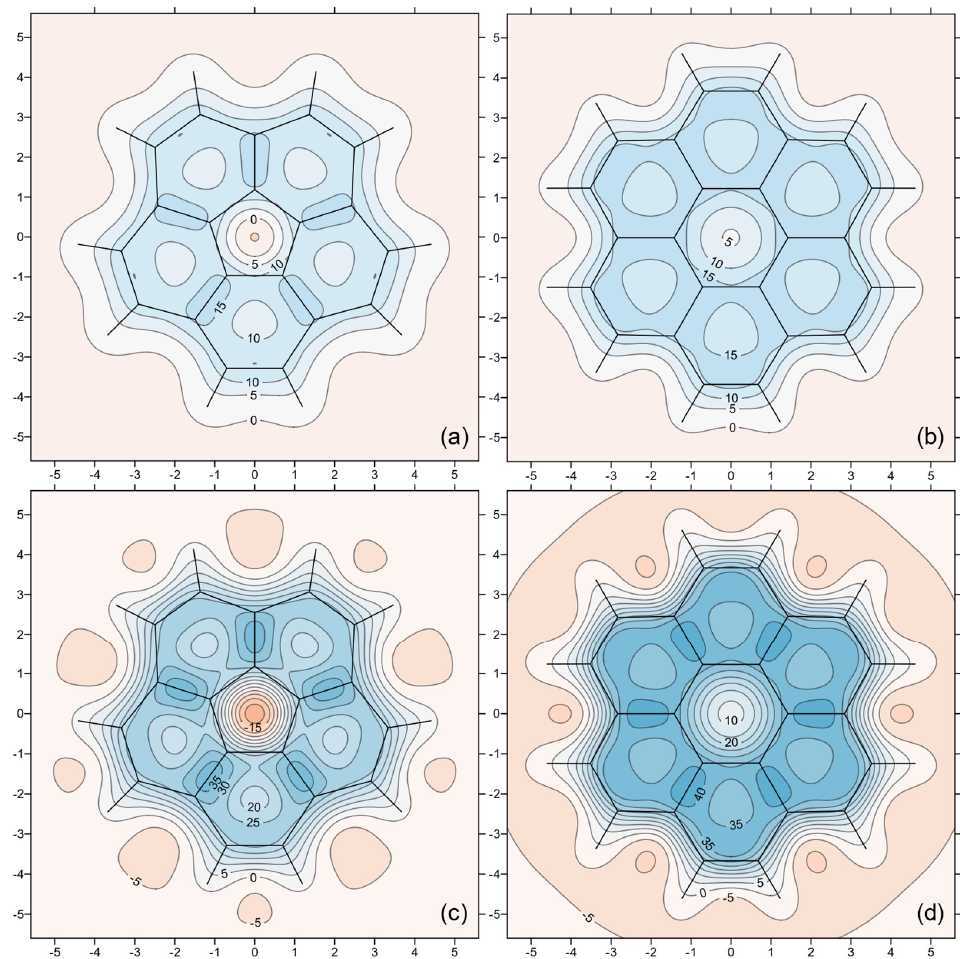
Figure 5. σ iso ( r ) ( a , b ) and σ zz ( r ) ( c , d ) contour plots for D 5h corannulene ( a , c ) and D 6h coronene ( b , d ) in planes 1 Å above the respective molecular planes, details as for Figure